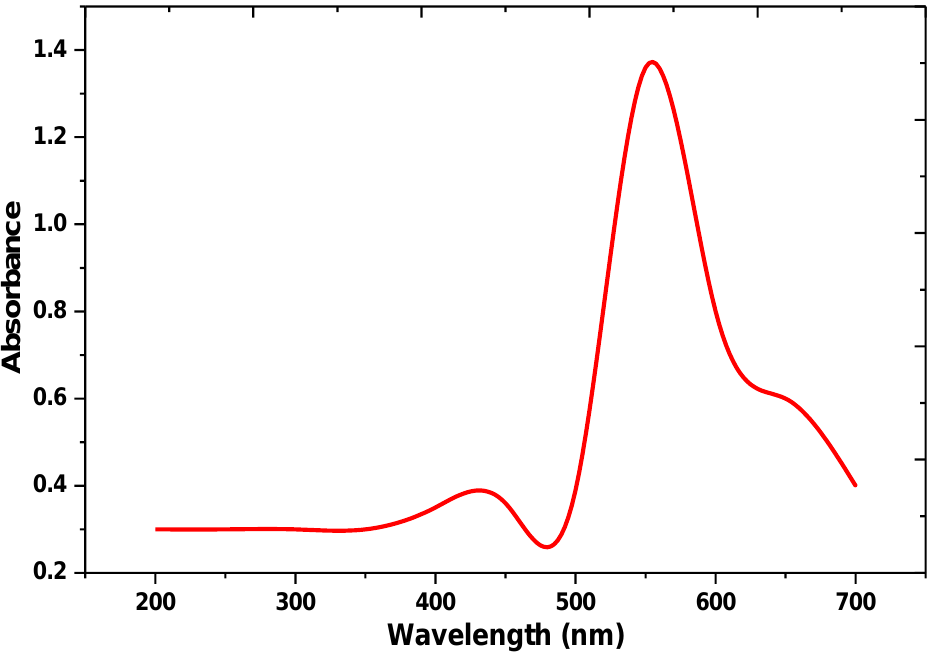
Figure 6. Ultraviolet spectroscopy patterns of Al 2 O 3 nanoparticles .